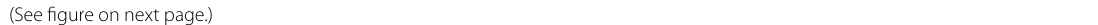
figure on next Fig. 3 Temporal changes in pulmonary function of ICU survivors of severe SARS‑CoV‑2 infection at 3, 6 and 12 months after symptoms onset. Graphs shows temporal changes in DLCO z‑score ( A ), 6MWT walked distance ( B ) or SF36 General health ( C ) at 3, 6 and 12 months after SARS‑CoV‑2 symptoms onset. Data are median (IQR). Horizontal dotted line indicate the normal cutoff of z‑score < LLN. DLCO diffusing capacity of the lung for carbon monoxide; 6MWT six‑minute‑walk test; SF36 Short Form 36‑item